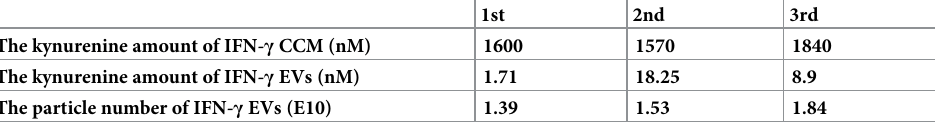
Table 3. Three data sets: IFN- γ EV kynurenine content, IFN- γ CCM kynurenine content, and the IFN- γ EV parti- cle count.